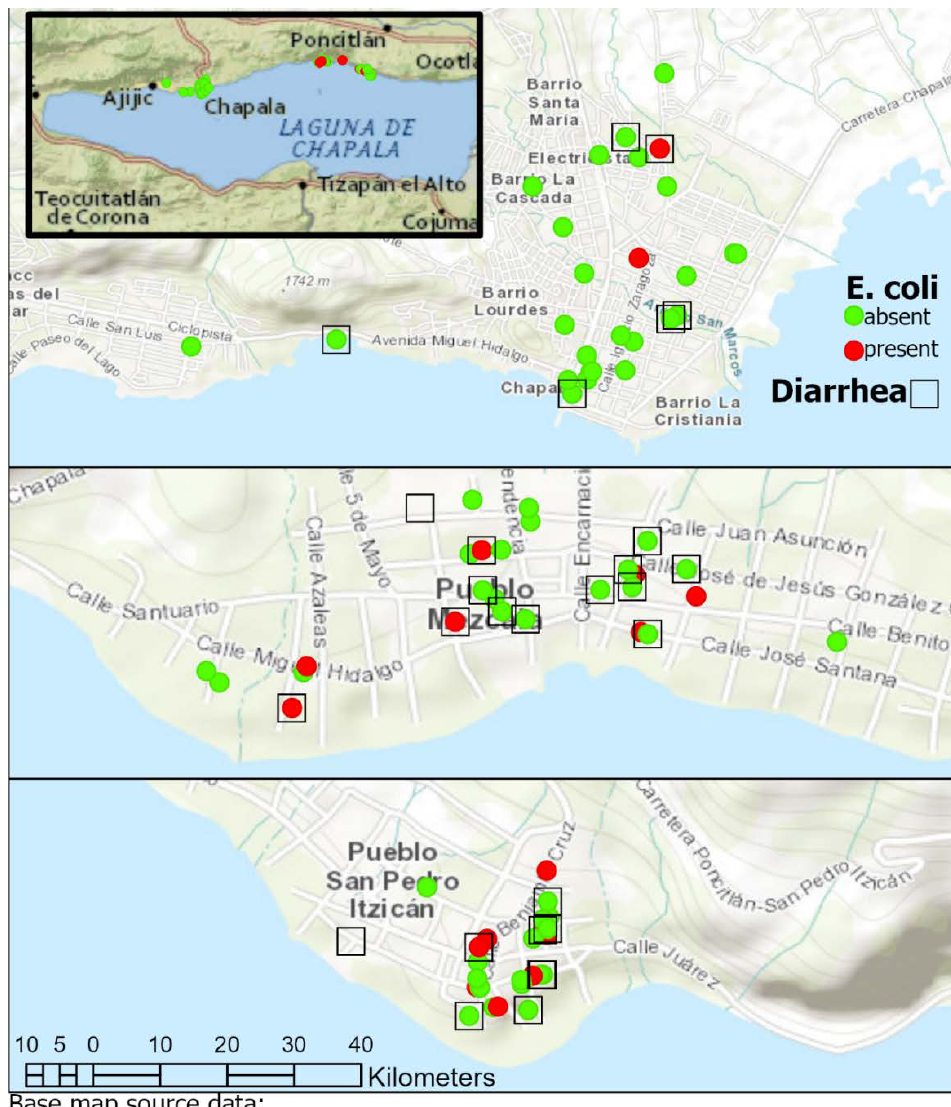
Figure 3. Presence of E. coli relative to diarrhea in Chapala (top), Mezcala (Middle) and San Pedro Itzicán (bottom). Inset shows the municipalities of Chapala and Poncitlán and relative locations of the three towns (left to right: Chapala, Mezcala, San Pedro Itzicán).